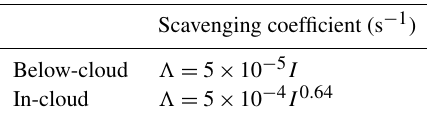
Table 1. Wet deposition schemes (Quérel et al.,